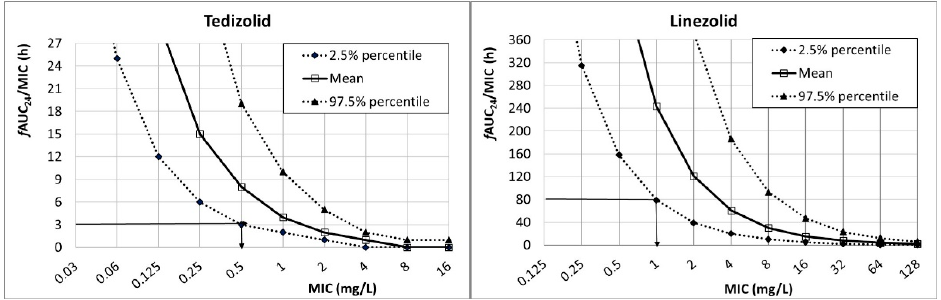
Figure 1. Relationship between f AUC 24 /MIC and MIC for tedizolid (200 mg q24h) and linezolid (600 mg q12h).